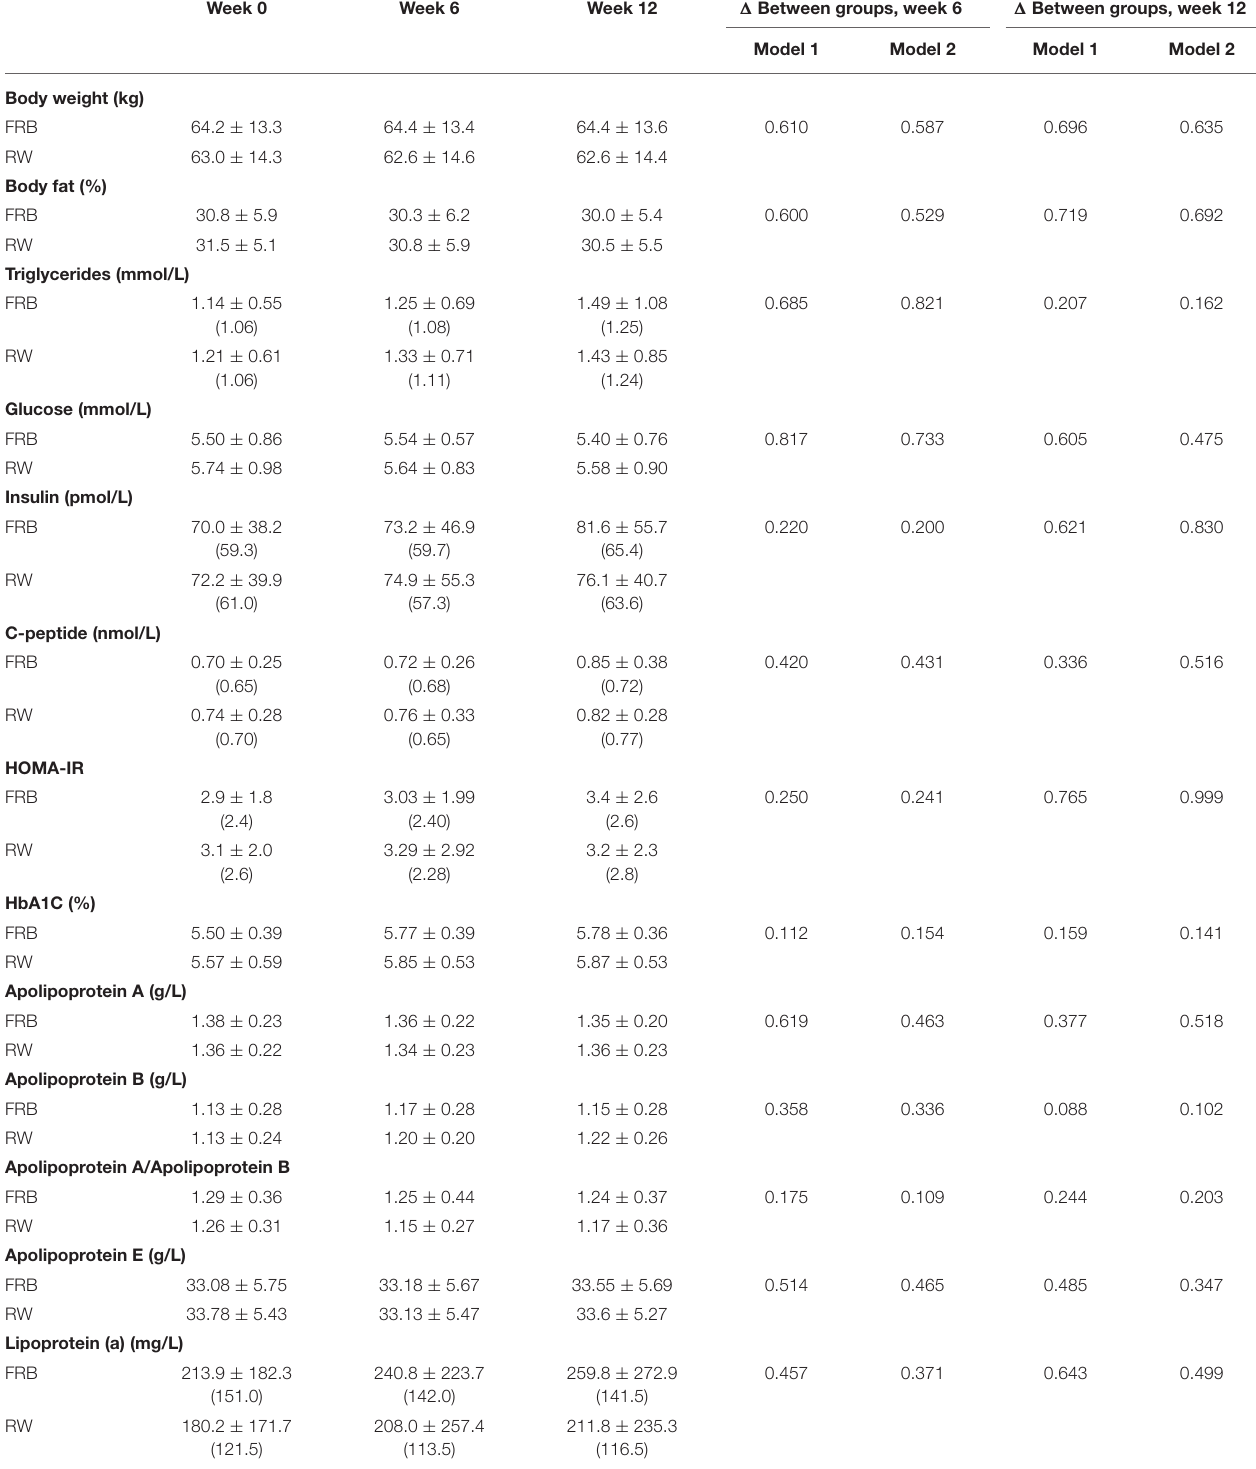
TABLE 4 | Effects on anthropometrics and clinical outcomes. Week 0 Week 6 Week 12 1 Between groups, week